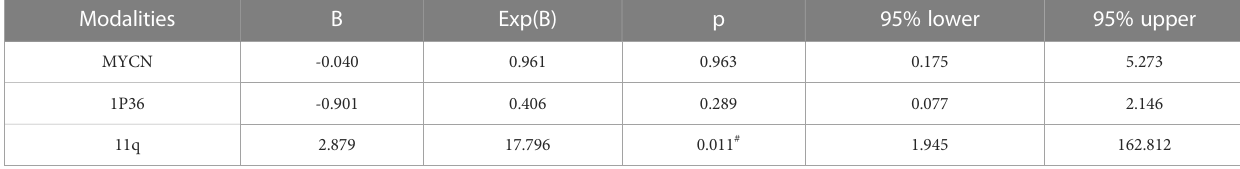
TABLE 3 MYCN oncogene status, chromosome 11q and 1p36 status as factors in fl uencing bone marrow in fi ltration.